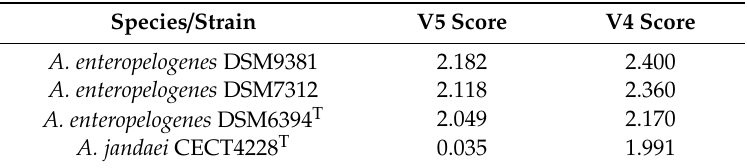
Table 1. Results obtained with MALDI-TOF Biotyper in two independent laboratories with di ff erent versions of the Biotyper database (V5 and